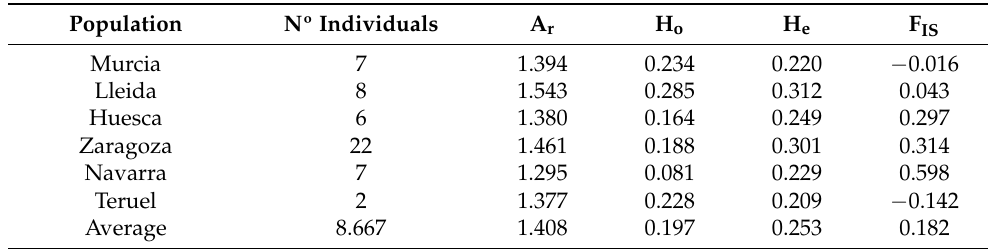
Table 3. Genetic diversity measures per population Allelic Richness (A r ), Observed Heterozygosity (H o ), Expected Heterozygosity (H e ), and inbreeding coefficient per population (F IS ) obtained with the DiveRsity package.